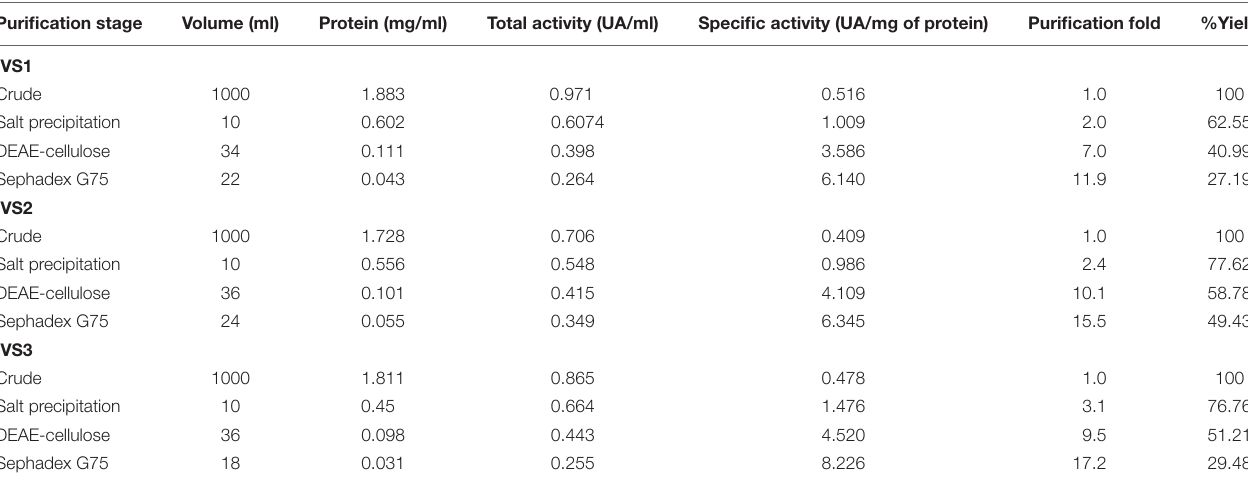
TABLE 1 | Midgut bacterial protease